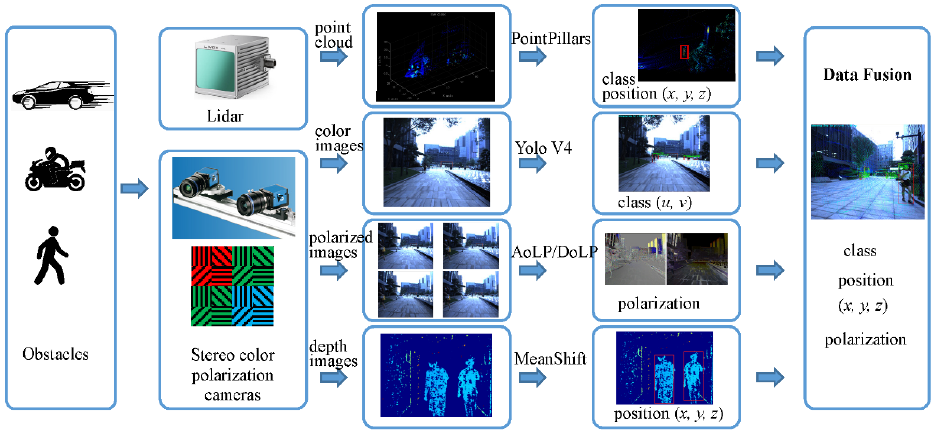
Figure 1. The proposed multiple target detection, recognition and fusion framework for ADAS.